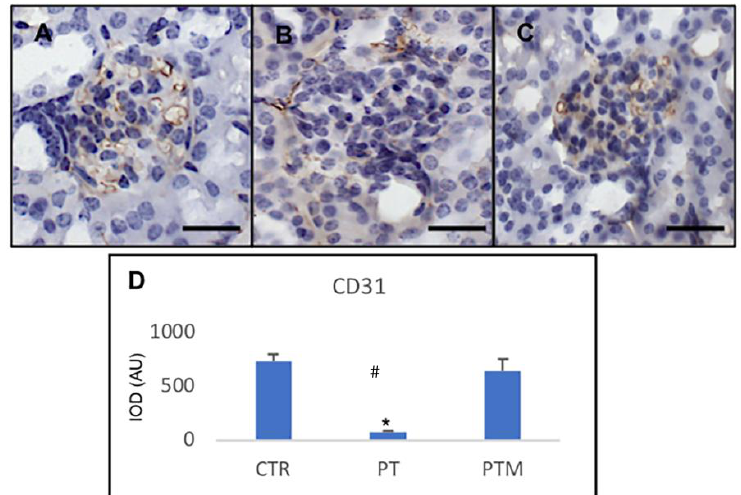
Figure 7. Photomicrographs showing transforming CD31 immunohistochemistry of control mice ( A ), pristane-LN mice ( B ) and pristane-LN mice treated with melatonin ( C ). Bar equals 20 µ m. The graph ( D ) summarizes CD31 immunohistomorphometrical analysis of all experimental groups. * # indicate respectively statistically significant di ff erences vs. control and pristane-LN mice treated with melatonin: * p < 0.05. CTR: control mice PT: pristane-LN mice PTM: pristane-LN mice treated with